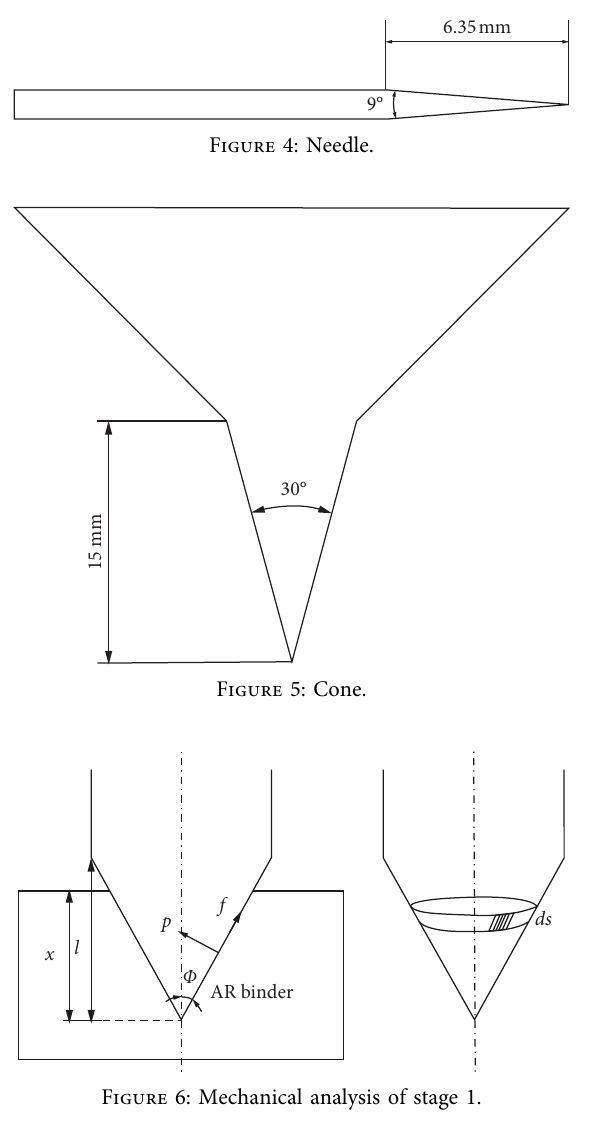
Figure 6: Mechanical analysis of stage 1.